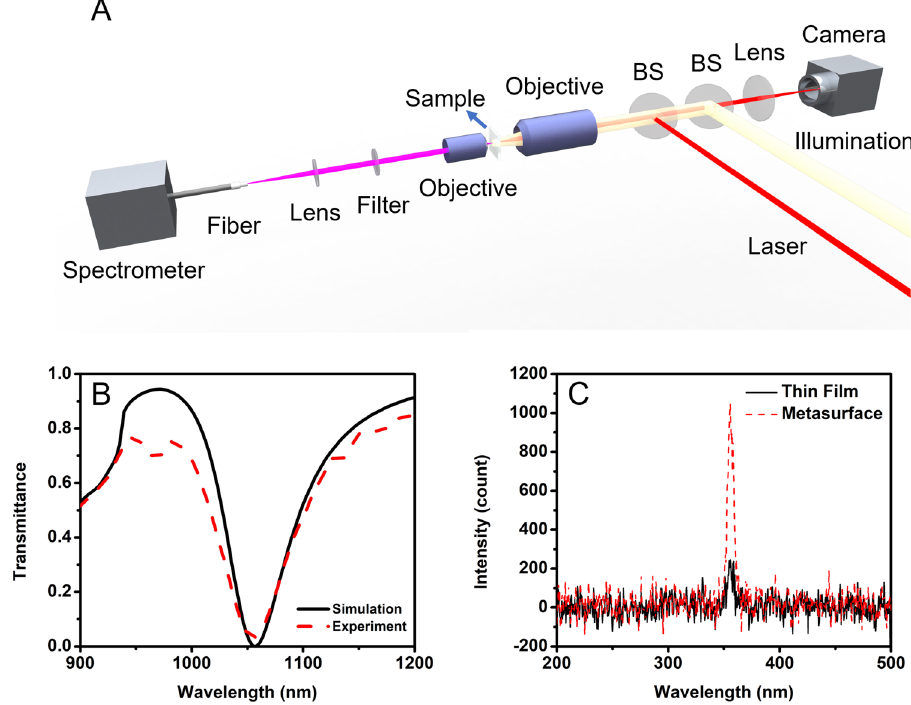
Fig. 3 Third harmonic generation measurements results. A Schematic illustration of the experimental setup. B Measured transmittance of the fabricated sample. The transmission dip appearing at around 1054 nm is in agreement with numerically simulated transmittance and experimental results. C Third harmonic intensity was measured for the uniform thin fi lm and for nanowire-based metasurface. The intensity of the THG from the metasurface is about 5.5 times larger than that from the reference 300-nm-thick As 2 S 3 thin fi